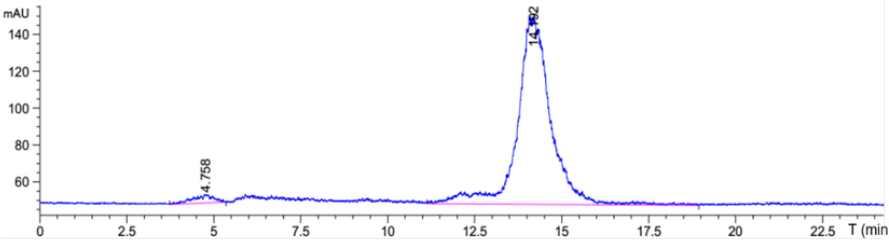
Figure 3. Radio-synthesis and HPLC radio -chromatogram of 99m Tc-HYNIC-ADH-1